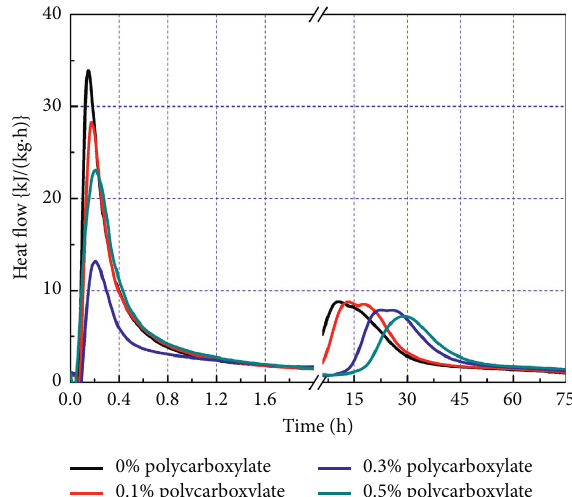
Figure 3: Effect of PCE-2 dosage on the hydration heat flow of cement pastes.